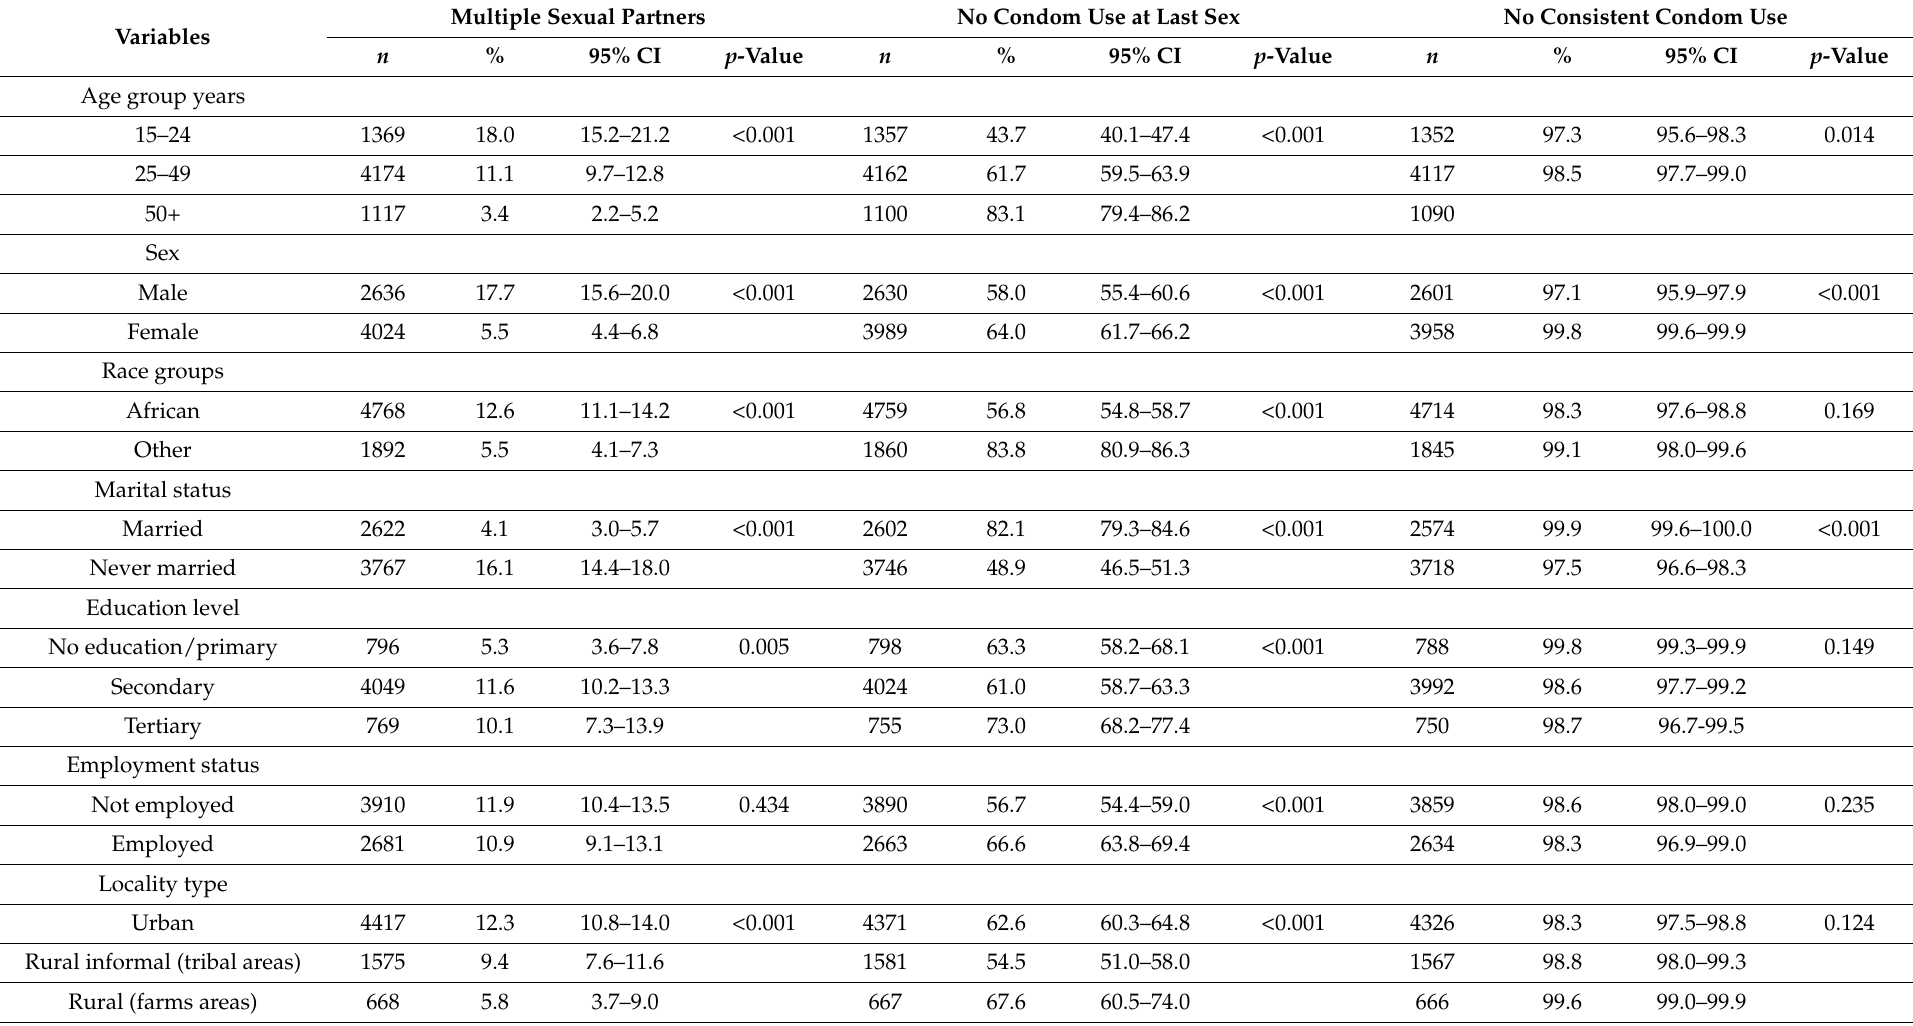
Table 2. Distribution of risky sexual behaviours by socio-demographic and alcohol use characteristics, South Africa 2017